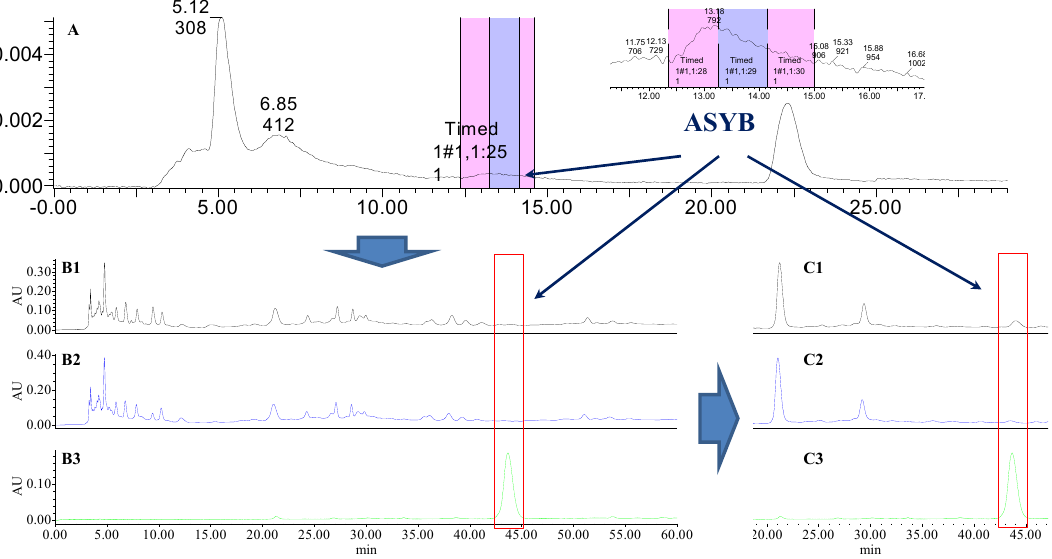
Figure 12. The preparative and analytical chromatograms of the depletion of ASYB from CF-AR. ( A ) preparative chromatogram at 270 nm; ( B1 ) analytical chromatogram of CF-AR at 270 nm; ( B2 ) analytical chromatogram of CF-AR-B at 270 nm; ( B3 ) analytical chromatogram of ASYB depleted from CF-AR at 270 nm. ( C1 ) analytical chromatogram of CF-AR at 400 nm; ( C2 ) analytical chromatogram of CF-AR-B at 400 nm; ( C3 ) analytical chromatogram of ASYB depleted from CF-AR at 400